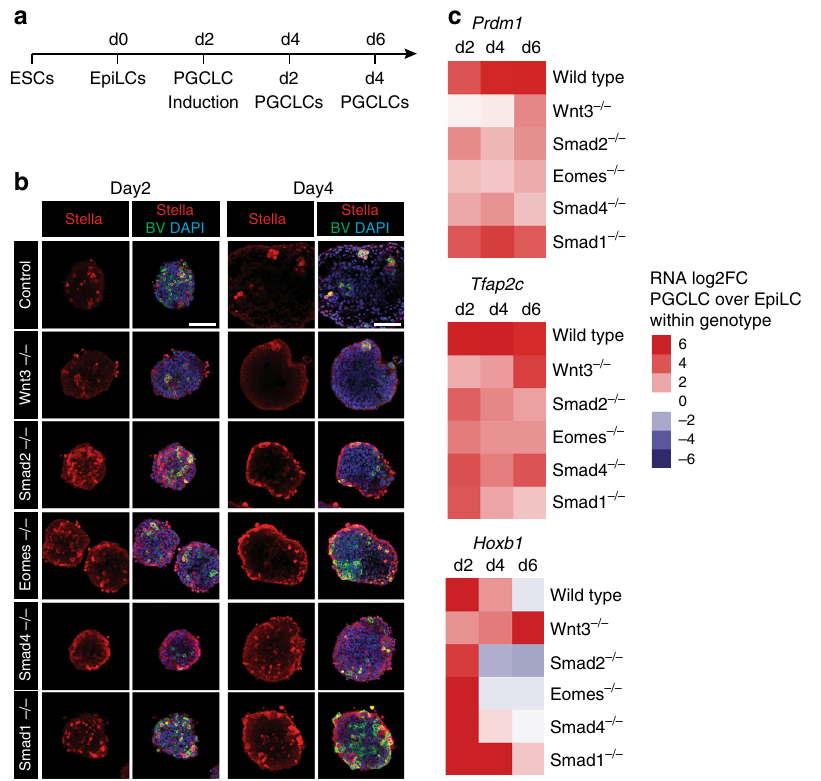
Fig. 4 Abilities of mutant ES cells lacking Nodal/Bmp/Smad pathway components to undergo PGCLC differentiation. a Time-line and culture protocol used for PGCLC differentiation. b Stella IF staining of day 2 and day 4 BV + PGCLC aggregates derived from the indicated genotypes, counter stained with DAPI. Scale bars = 100 μ m. c Heatmap showing the log2 fold changes (log2FC) of Prdm1, Tfap2c and Hoxb1 expression, as judged by RT-qPCR, at day 2, 4 and 6 of PGCLC differentiation in control and mutant cells of the indicated genotypes, relative to